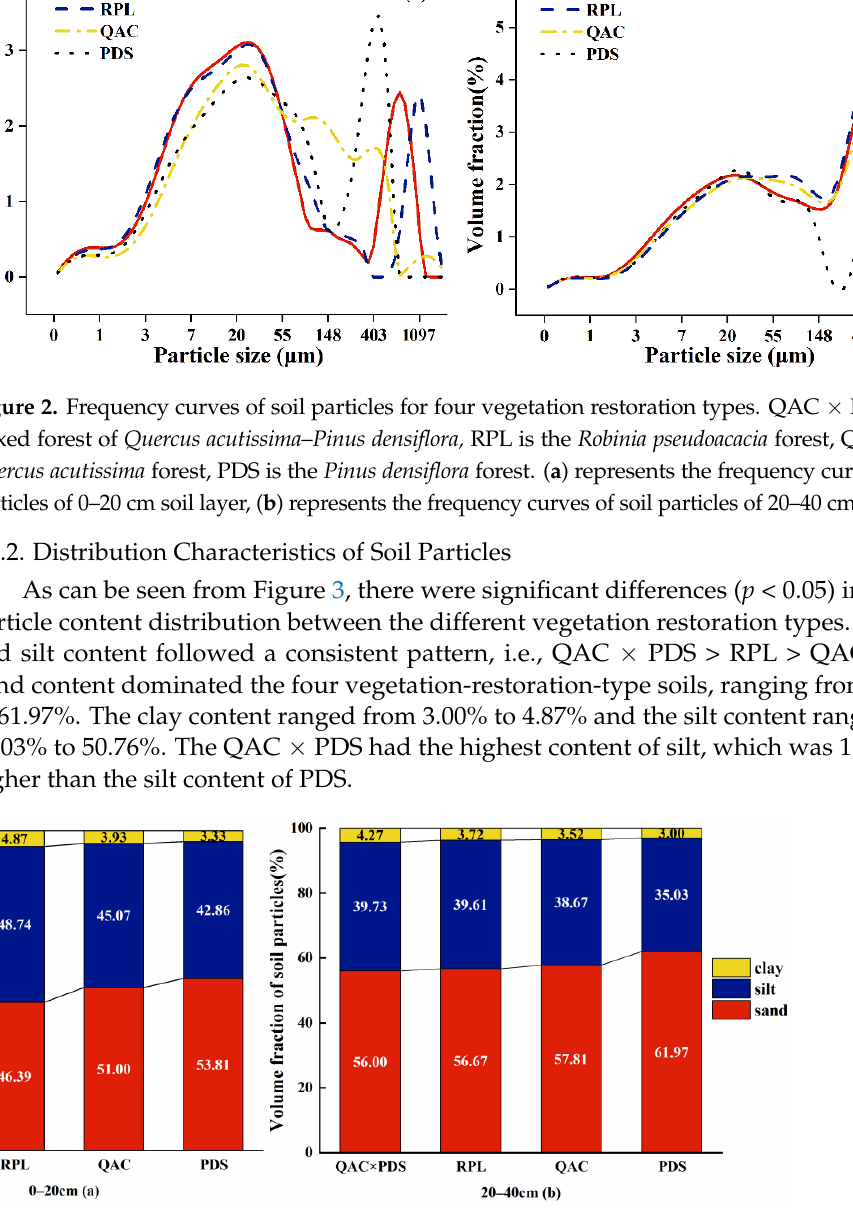
Figure 3. Soil particle composition of four vegetation restoration types. QAC × PDS is the mixed forest of Quercus acutissima – Pinus densiflora, RPL is the Robinia pseudoacacia forest, QAC is the Quercus acutissima forest, PDS is the Pinus densiflora forest. (a) represents the frequency curves of soil particles of 0-20cm soil layer, (b) represents the frequency curves of soil particles of 20-40cm soil layer. 3.2. Single Fractal Characteristics of Soil Particles of Four Vegetation Restoration Types The present study found significant differences in D values of four vegetation resto- ration types ( p < 0.05). The order of D values was QAC × PDS > RPL > QAC > PDS (Figure 4). It showed that QAC × PDS has the smallest soil particle size and the finest grain texture among the four vegetation types, and it was easy to form a soil structure with a good water and fertilizer retention effect. RPL and QAC were next, and PDS was the worst.